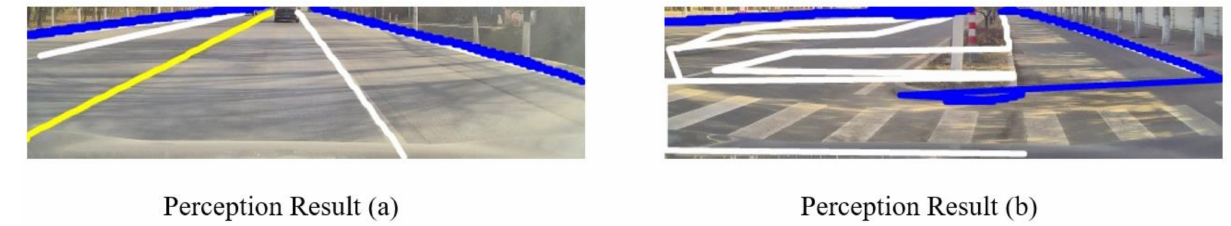
Figure 1. The perception result outputted from the perception model. The blue line refers to the road edges; the yellow line refers to the middle line of the road; the white line refers to the lane mark. The left image is the correct classification output, whereas the right image is the wrong classification output. The reason why these lines are not absolute linear is that the perception model outputs several points instead of lines that can represent the lane mark and road edges. Since the vehicle is running, the result will be unstable once the perception model output the